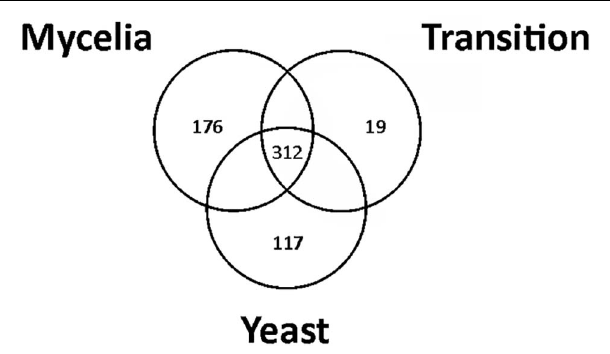
FIGURE 1 | Venn diagram showing the overlap of common proteins identified in mycelium, transition mycelium-to-yeast, and yeast cells. The numbers indicate the total of proteins differentially expressed in mycelium, transition mycelium-to-yeast, and yeast